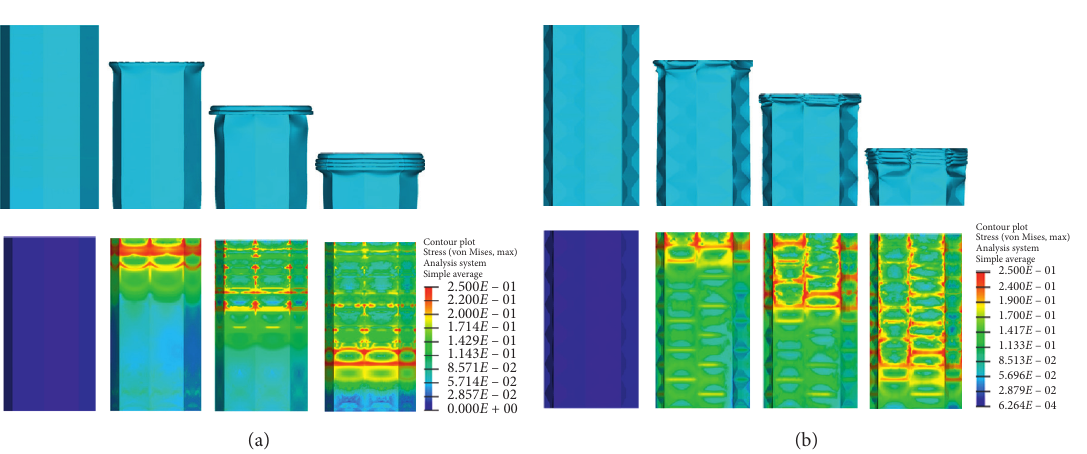
Figure 12: Crushing processes (top) and corresponding von Mises stress contour maps on undeformed patterns (bottom) of (a) OTC and (b) O6_R25_80.